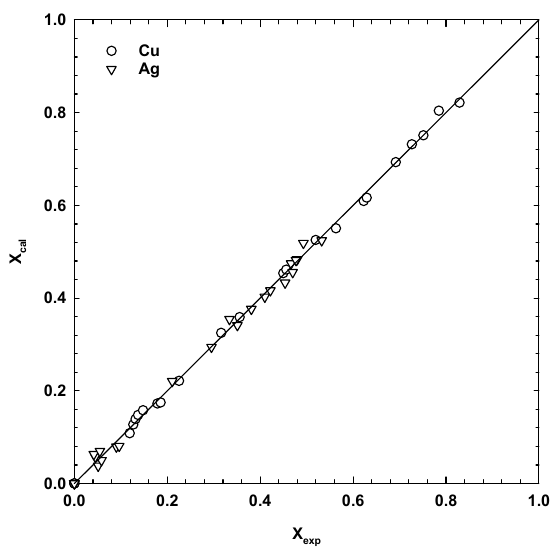
Figure 8. Comparison of the calculated (Equation (20)) and experimental values of fraction of Cu extracted at different temperatures (1 M H 2 SO 4 , 13.5 g/dm 3 MnO 2 , 1 M NaCl, 30 g/dm 3 SMS, 300 rpm).